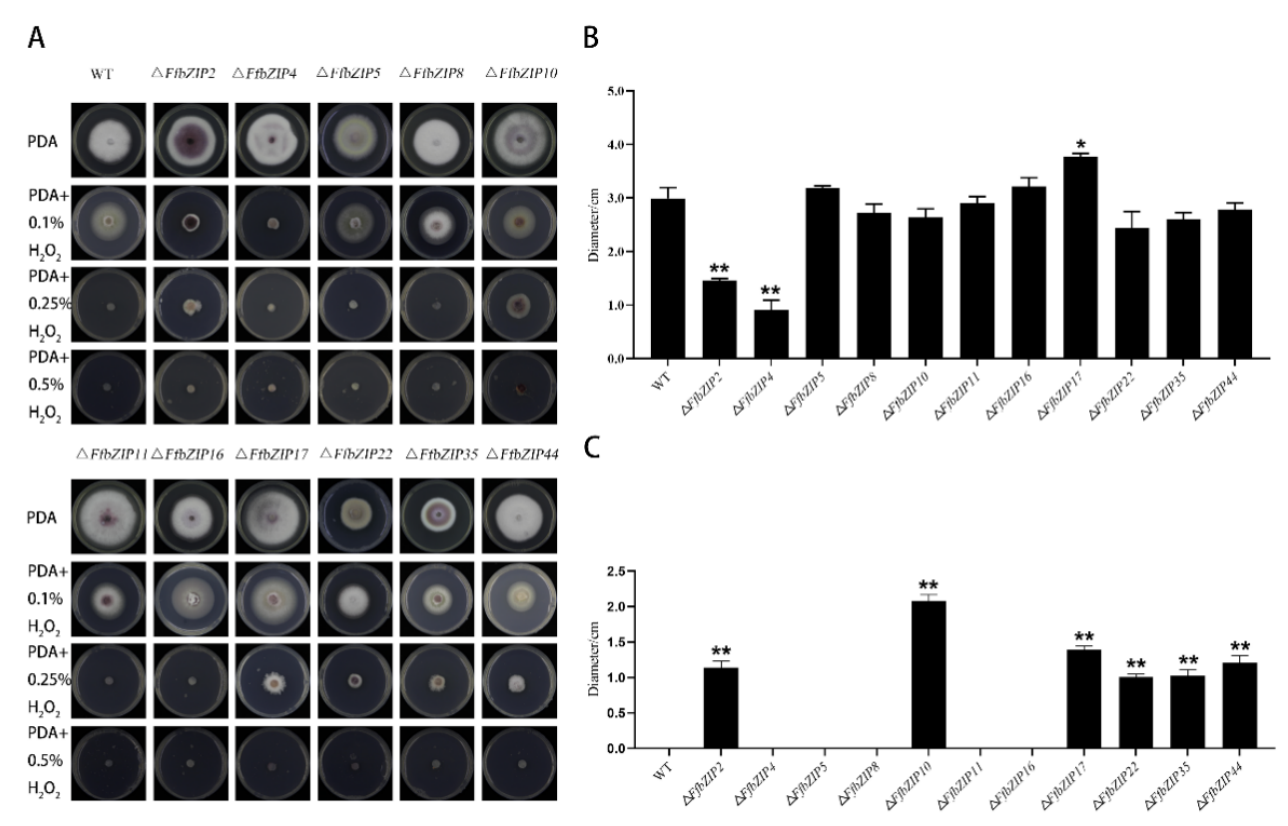
Figure 5. Oxidative stress experiment. ( A ) Growth of wild type and FfbZIP knockout mutants under exogenous oxygen stress. ( B ) Histogram of strain diameter under 0.1% H 2 O 2 oxidative stress. Error bars represent means ± SEs. ( C ) Histogram of strain diameter under 0.25% H 2 O 2 oxidative stress. Error bars represent means ± SEs. * p < 0.05, ** p < 0.01.